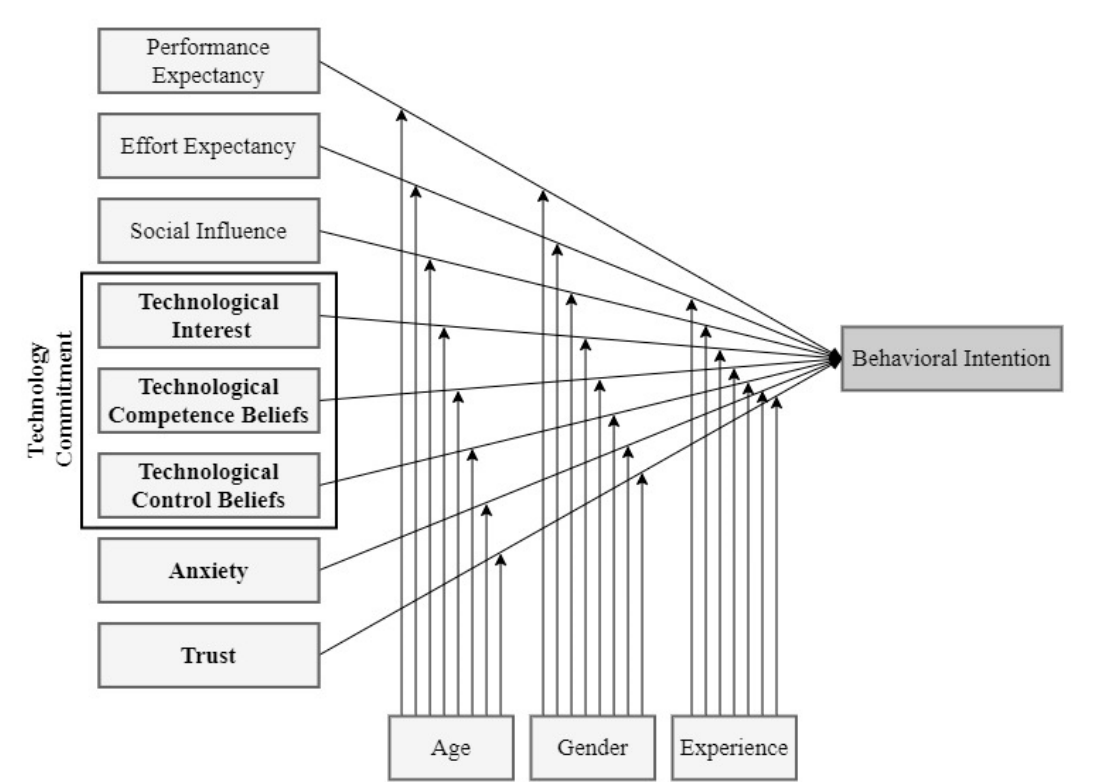
Figure 1. Modified UTAUT model in the context of AFR; bold letters = added factors.